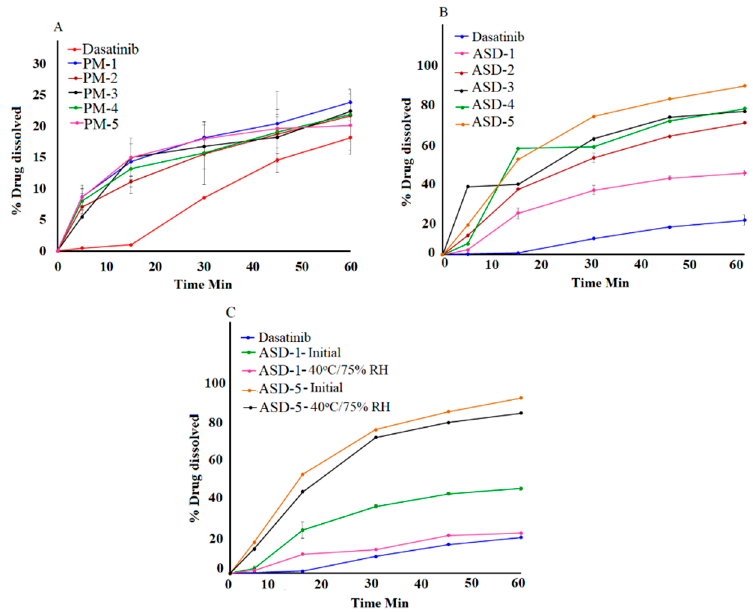
Figure 7. Dissolution profiles of ( A ) Physical mixtures ( B ) ASD-1 to ASD-5 ( C ) ASD-1, ASD-5 initial and 40 °C/75% RH exposed.